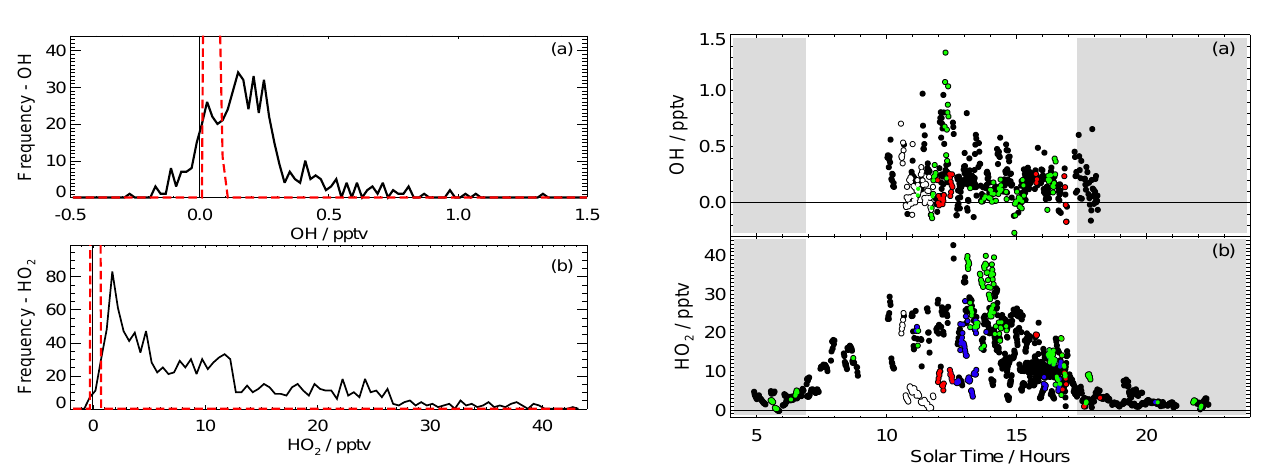
Fig. 11. Diurnal variation of (a) OH (pptv) and (b) HO 2 (pptv). Shaded areas indicate night. Specific data discussed in the text is highlighted: green points indicate high isoprene, red points are data identified as biomass burning, blue points indicate cloud sam- pling, white points highlight data high altitude data collected on flight